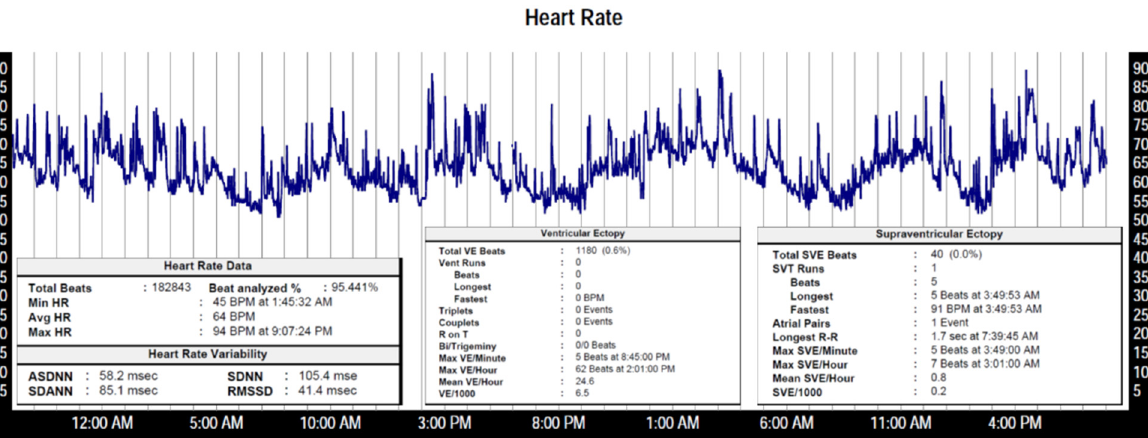
Figure 3. Typical graphical and textual presentation of a medical grade 48 h wearable ambulatory monitor (Holter). The heart rate trends between 45–94 bpm, with longer and shorter cycle length variations due to diurnal changes and variable activity levels. Valid data was collected during 95% of the monitoring interval, the rest was rejected due to inadequate signals. Heart rate variability parameters are automatically calculated. The percentage of ectopic, abnormal rhythms is also shown (premature atrial and ventricular contraction).